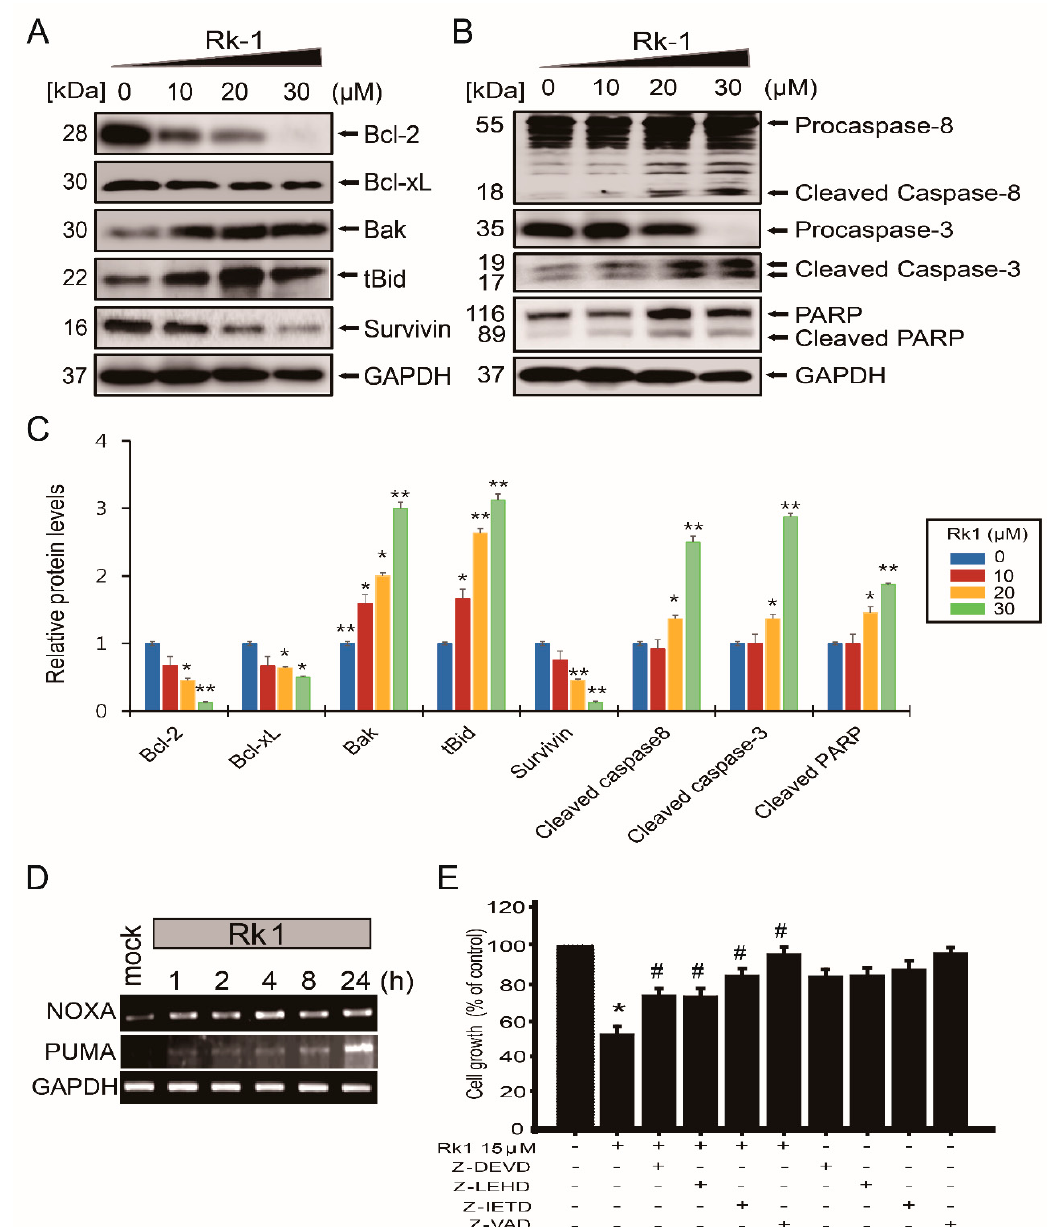
Figure 4. Rk1 induces apoptotic cell death in SK-N-BE(2) cells. ( A – C ) SK-N-BE(2) cells were treated with various concentrations of Rk1 for 24 h. Apoptotic markers were analysed by western blotting and GAPDH was used as a protein loading control. ( C ) Data are presented as mean ± SD three independent experiments. * p < 0.05 and ** p < 0.01 versus control. ( D ) The mRNA expression levels of the pro-apoptotic genes NOXA and PUMA were evaluated using RT-PCR and GAPDH was used as an internal control. ( E ) The effect of caspase inhibitors on apoptosis was determined by MTT assay. Caspase inhibitors reversed cell death by Rk1. Data are presented as mean ± SD three independent experiments. * p < 0.05 vs. control group. # p < 0.05 vs. Rk1 only treated group.